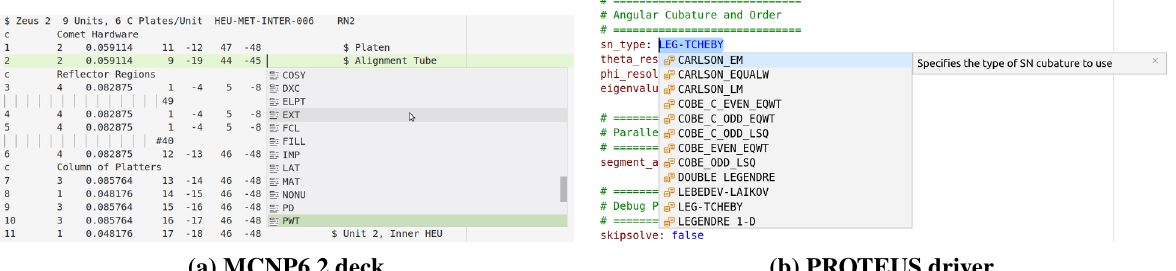
Figure 1: Content-assist and autocompletion for MCNP and PROTEUS